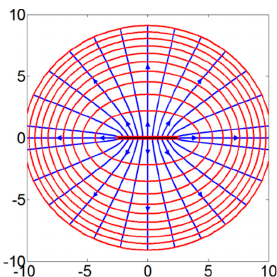
Figure 6. Fluid injected via hydraulic fractures of uniform conductivity with streamlines (blue) and time-of-flight contours (TOFCs, red). Total TOF is 10 years and TOFC spacing is 1 year. Interval source parameters: z c = 0 + 0 × 1 i , q ( t ) = 1.84 × 10 − 7 m 3 /s, h = 1 m, n = 0.2, L = 5 m, β = 0° and Δ t = 0.1 day. After Van Harmelen and Weijermars [9].